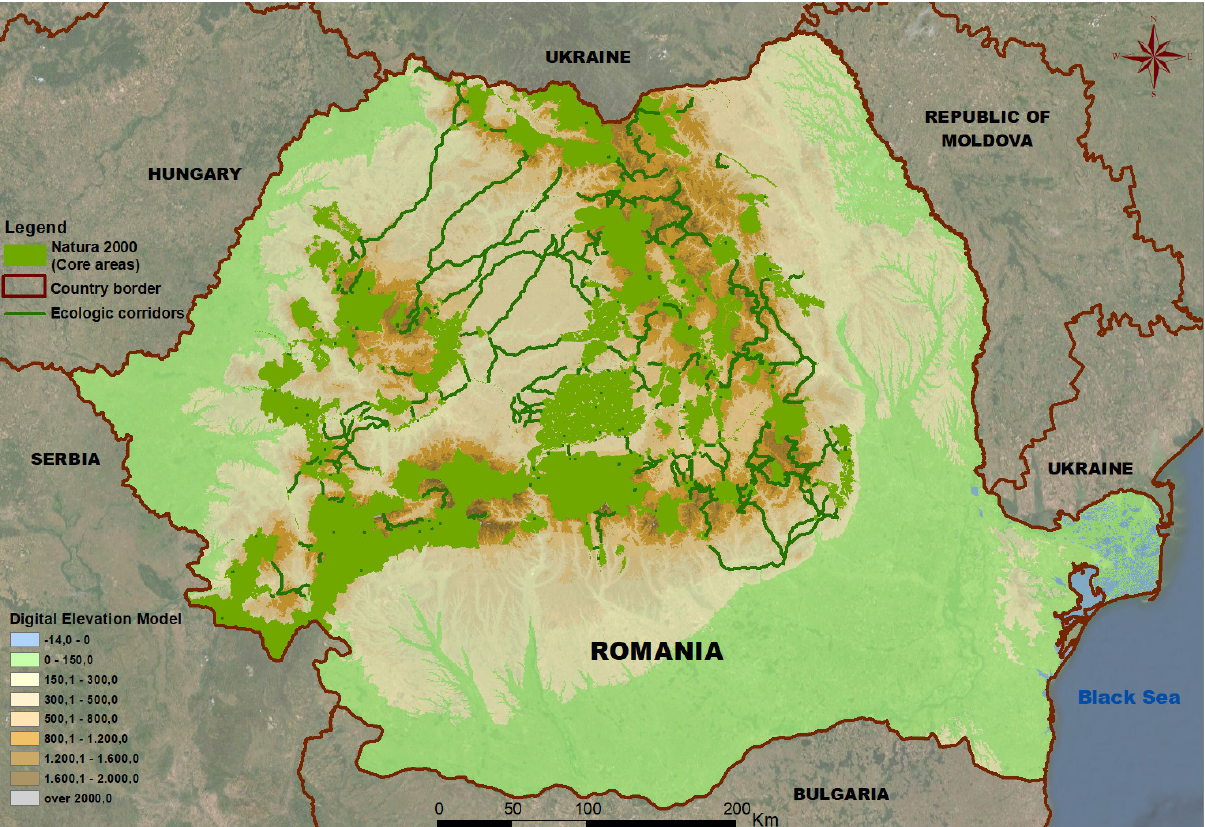
Figure 5. Map of the ecological network for the brown bear in the Romanian Carpathian Mountains (ecological corridors and core areas). The final map shows the possible ecological corridors for the brown bear between core areas (Natura 2000 sites).